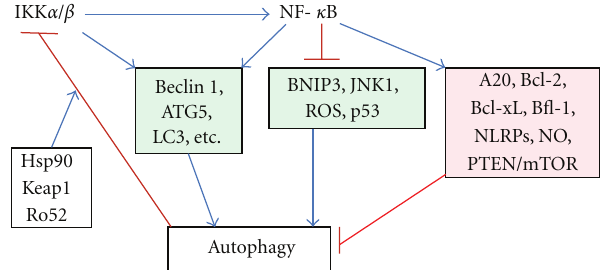
Figure 1: The context-dependent regulation of autophagy via the functional interactions between IKK-NF- κ B signaling axis and autophagy. IKK α / β and NF- κ B can increase the expression of Beclin 1 and other autophagy-related proteins and stimulate autophagocytosis. On the other hand, increased autophagy can degrade IKK components and repress autophagy. Hsp90, Keap1, and Ro52 enhance the autophagic degradation of IKK components. In addition, NF- κ B signaling increases the expression of autophagy repressors, for example, A20, Bcl-2/Xl, and NLRP receptors. Moreover, NF- κ B can suppress many inducers of autophagy, for example, BNIP3, JNK1 and